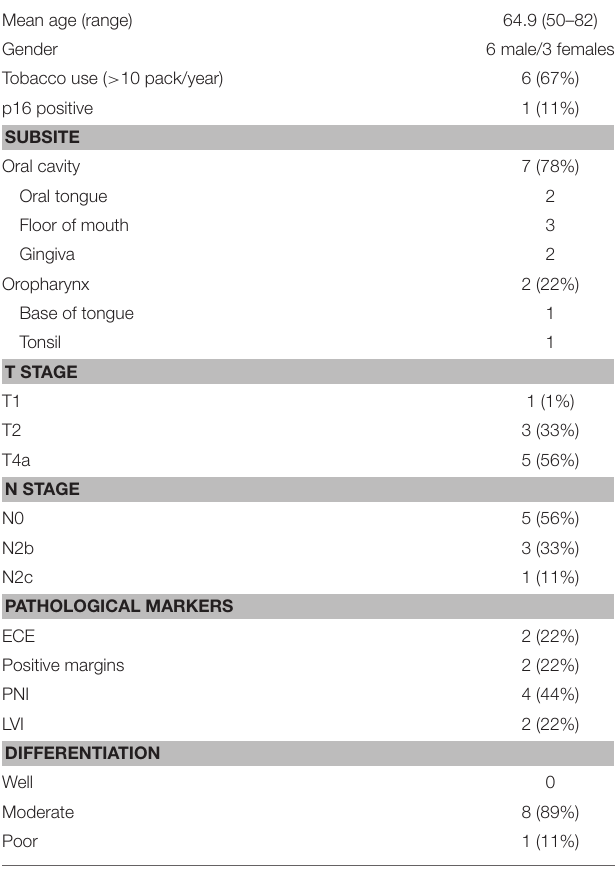
TABLE 1 | Demographics and Pathologic characteristics. Mean age (range)